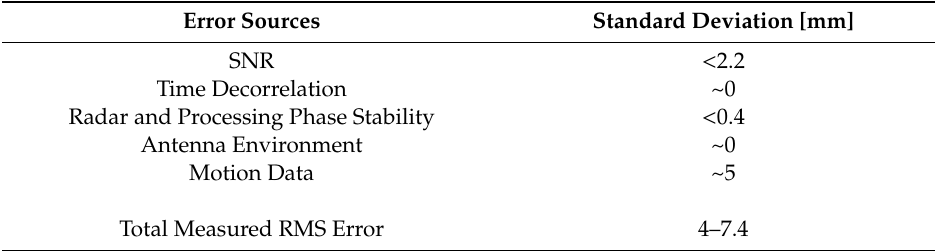
Table 6. Error source budget of the deformation map. There are five sources and a total measured error of about 4–7.4